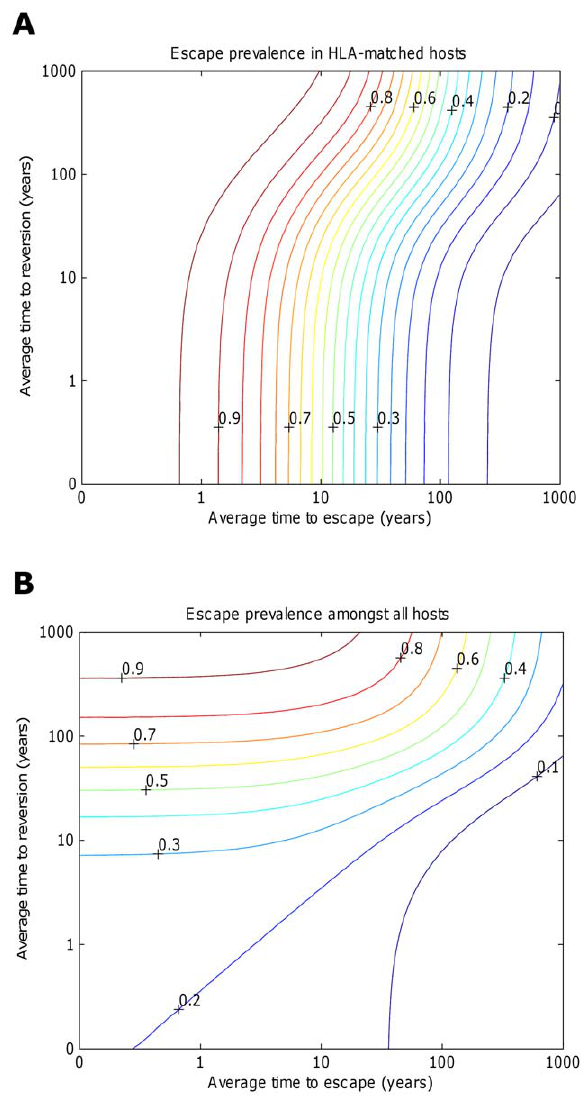
Figure 5. Contour plots showing how the prevalence of escape amongst A) HLA matched hosts and B) all hosts varies according to the escape and reversion rate. These contour plots explore how the prevalence of escape 200 years intoanepidemic varies according tothe rate of escape in HLA matched hosts and the rate of reversion in HLA mismatched hosts. Vaccination is applied to all hosts in the population 50 years into an epidemic. Escape is assumed to occur at the same rate at each epitope. Reversionis assumed tooccur at the same rate at eachepitope and revert at the same rate. At each epitope, escape rates in vaccinated and unvaccinated HLA-matched hosts are assumed to be equal ( w i ~ ~ ww i for i =1:5). The escape and reversion rates are presented in terms their reciprocal – the average time to escape ( x -axis) and average time to reversion( y -axis).The contours showthattheprevalence ofescape amongst A) HLA-matched hosts and B) all hosts increases as the rate of escape increases and the rate of reversion decreases; however, the increase in escape prevalence inHLA-matched hosts with reversionrate is limited when revision takes an average of 10 years or less. The assumptions and parametersusedinthesefiguresarethesameasthosedescribedforFigure2 except that the infectiousness and life expectancy of successfully vaccinated hosts are fixed at ~ bb c ~ 0 : 008 and m z ~ aa ~ 1 = 50 , respectively ( L vac ~ 0 : 4 control strategy. It is perhaps worth highlighting here, that whilst R 0 ~ L unvac , R C is not equal to L vac . Whereas L vac describes the lifetime transmission potential of a specific host type (vaccinated